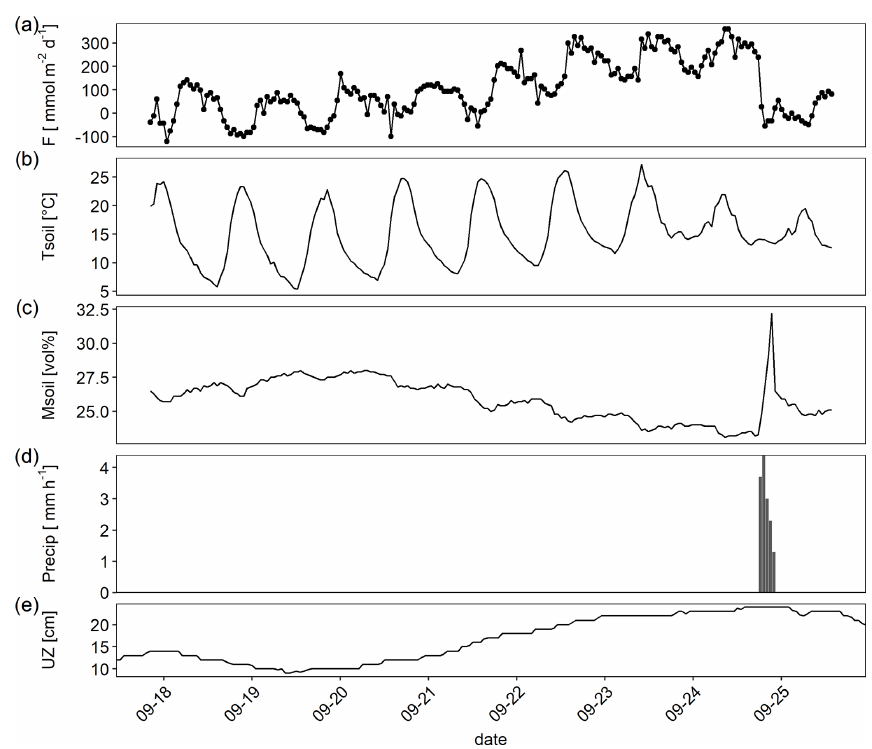
Figure 4. Example high-frequency dataset showing (a) CO 2 flux ( F ) measured by an automatic chambers, (b) sediment temperature (Tsoil; 0–5cm depth), (c) sediment moisture (Msoil; 0–5cm depth) (d) precipitation (Precip) recorded in hourly resolution, and (e) thickness of the unsaturated zone (UZ; distance between water table level and ground